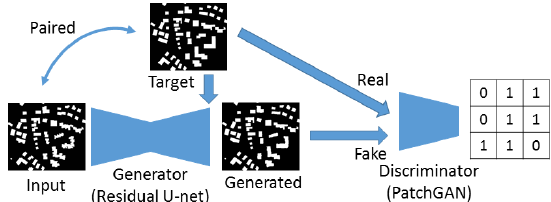
Figure 4. PatchGAN as GAN